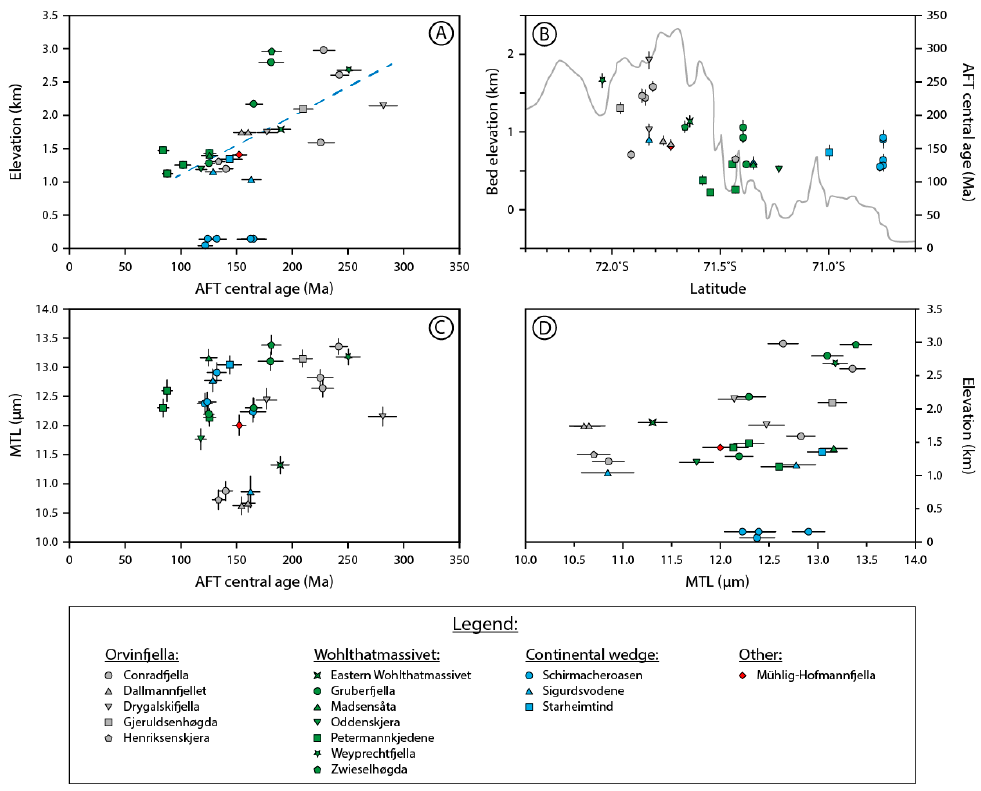
Figure 4. Apatite fission track ages from 31 samples. Reported errors for AFT ages are 1 σ ,